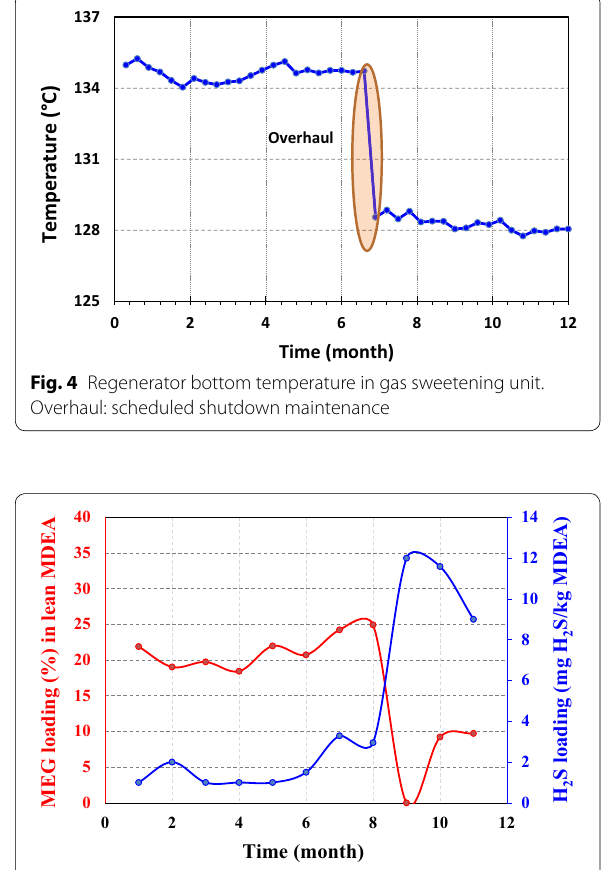
S concentration in sweet gas obtained from the simulation for 1 to 25 wt% MEG content in the amine solution 2